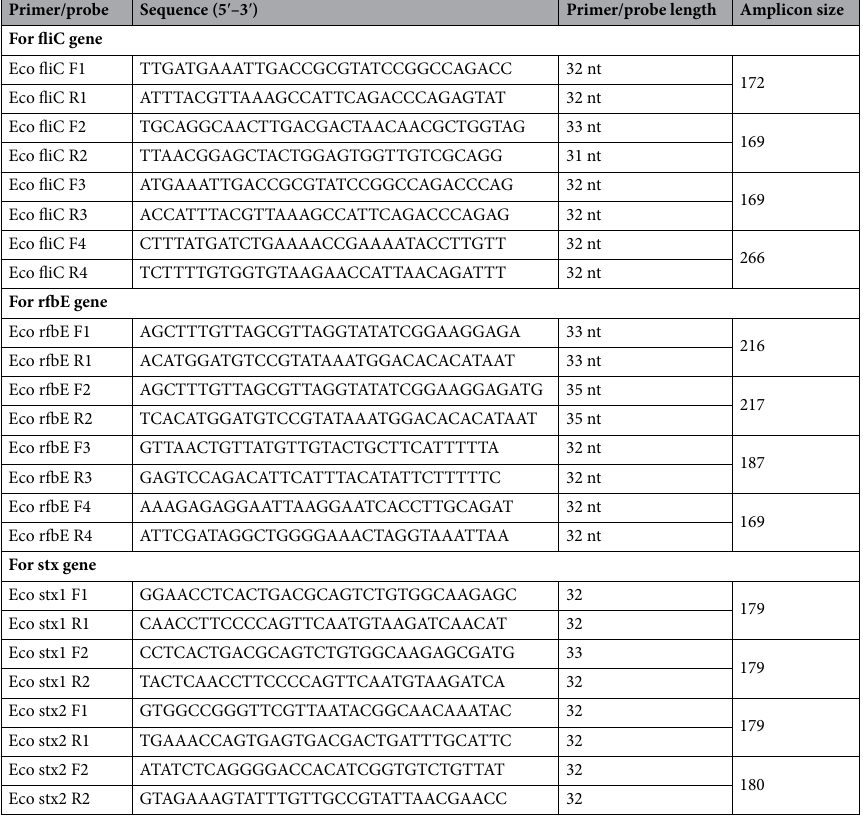
Table 1. A list of all primers tested in this study. FP forward primer, RP reverse primer, nt